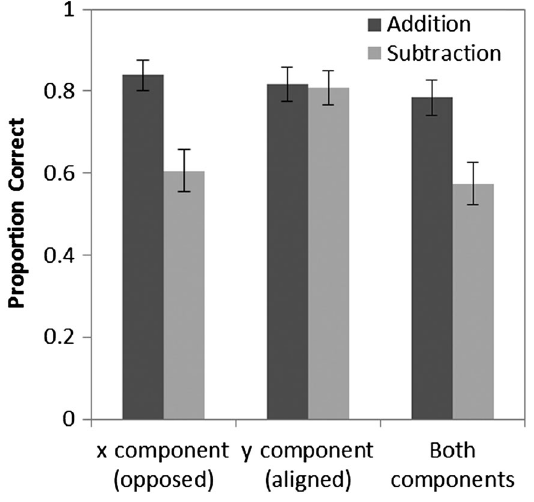
FIG. 4. Student performance ( N ¼ 187 , semester 1) on addition and subtraction of two vectors in the arrow format for questions in which the x components were in opposing directions and the y components were in the same direction (see Fig. 3, left-hand side). The categories represent proportion of students correctly adding (or subtracting) the x components, which are in opposing directions, the y components, which are pointed in the same direction, and the combined total scores of both components. Error bars indicate (cid:2) 1